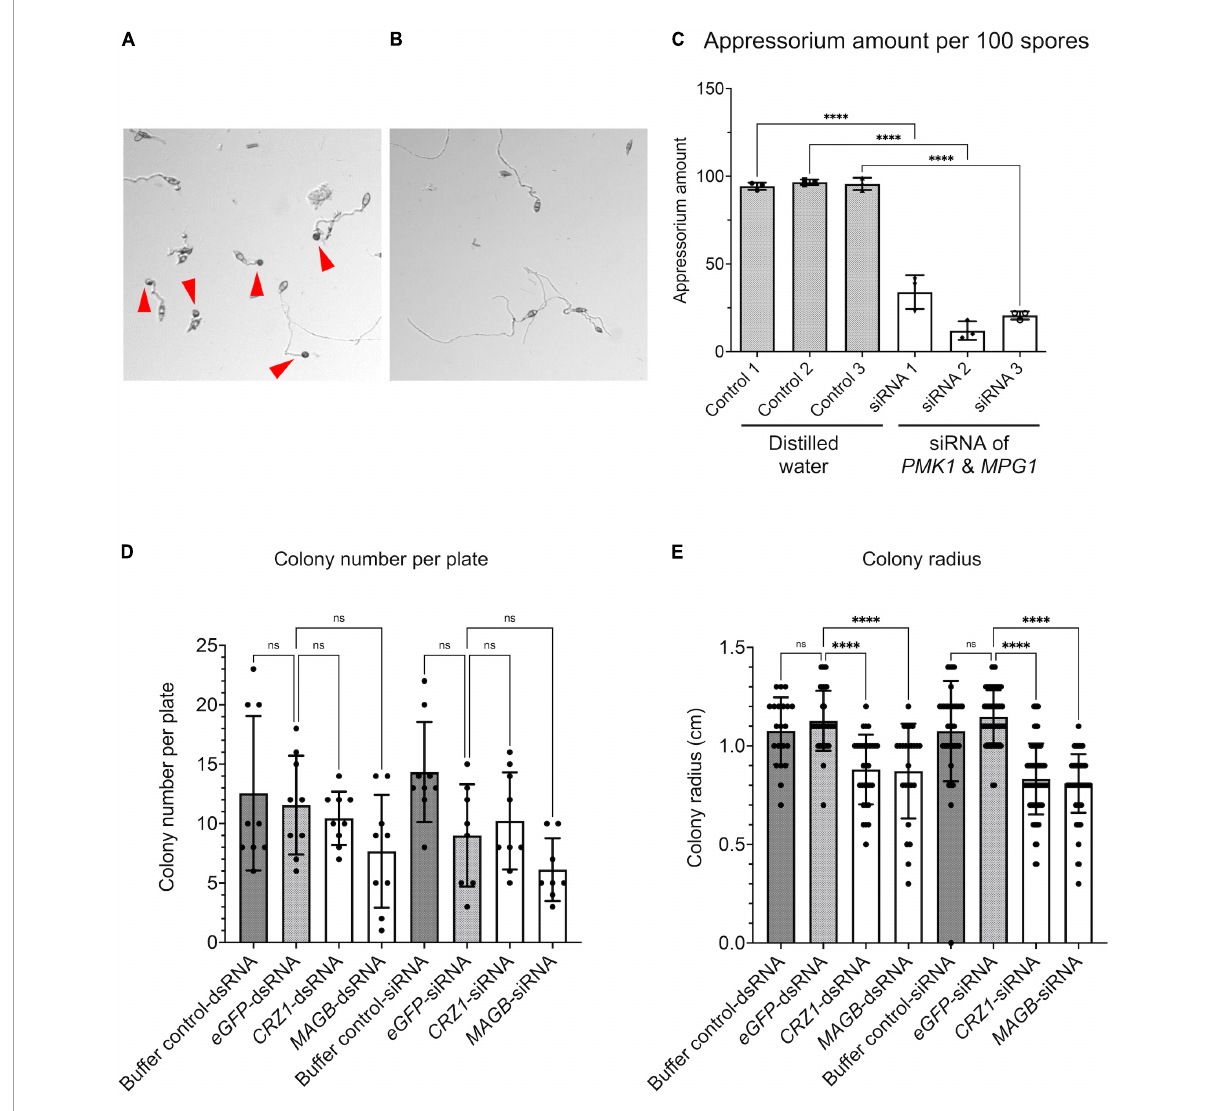
FIGURE8 RNA silencing signals can be absorbed by Magnaporthe oryzae resulting in functional collapse. (A) Spore suspension treated with distilled water. Appressoria (red arrows point to appressoria) were formed at tips of germ tube. (B) Spore suspension treated with siRNA derived from PMK1&MPG1, less appressoria were formed. (C) Appressorium amount after water treatment and PMK1&MPG1 siRNA treatment. Ordinary one-way ANOVA and Turkey’s multiple comparison were used for statistics analysis. (D) No statistical difference was observed considering fungal colony number when spore suspensions were treated with buffer control, dsRNA/siRNA derived from eGFP, CRZ1 or MAGB . (E) Treatment of dsRNA/siRNA derived from CRZ1/MAGB reduced fungal colony radius when compared to spore suspensions treated with buffer control or eGFP -dsRNA/siRNA. Buffer solution was negative control solution that went through the whole process of dsRNA/siRNA synthesis but without templates. **** P < 0.0001, ns: not